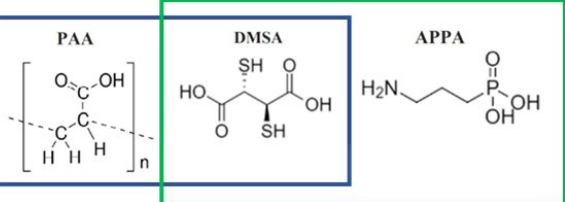
Figure 1. Structure of the different coatings used: PAA, DMSA, APPA. In the Figure, the two sets of samples coatings are also indicated: in the blue box, the coatings used for the smallest MNPs ≈ 4.4 nm); in the green box, the coatings used for the biggest MNPs ( d s ( d s 1 Synthesis of 4.4-nm iron oxide-based MNPs. A mixture of Fe(acac) 3 (0.7064 g, 2